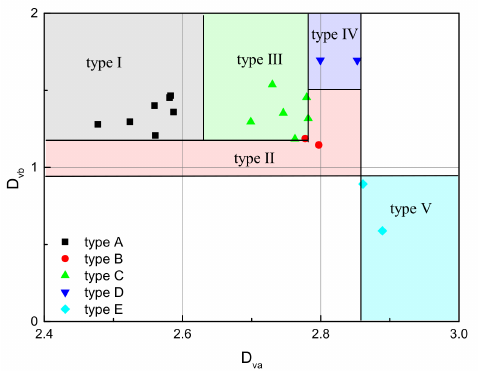
Figure 4. Pore structure classification based on D va – D vb cross